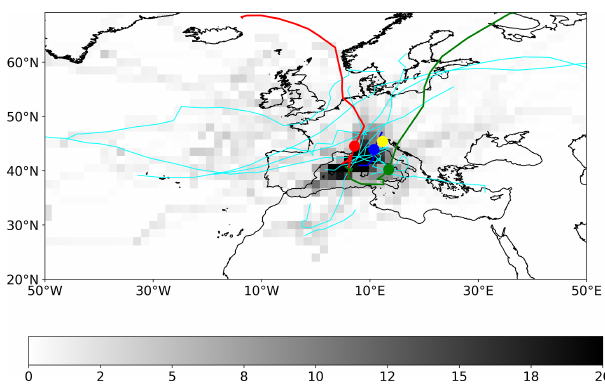
Figure 6. Density of tracks of cyclones associated with storm surges contributing to water height maxima above 110cm (relative fre- quency of cyclones for each cell of 1.5 in percentage of total; grey bar in the panel; based on ERA5). Cyan tracks represent the events reported in Table 1 with water height maxima of 140cm (see Ta- ble 1); the red, green, and blue tracks represent the 29 October 2018, 12 November 2019, and 4 November 1966 events (the blue track is based on ERA40 data). The yellow dot represents the location of the city of